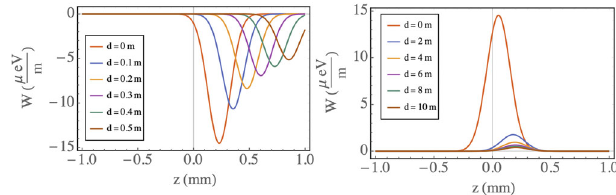
FIG. 2. The drift space CSR ’ s boundary terms [Eq. (2)] energy modulation along the bunch ’ s internal coordinate, z , for various positions along the drift. Left: The transient wake containing the z C slippage term. Right: The transient wake containing the slippage